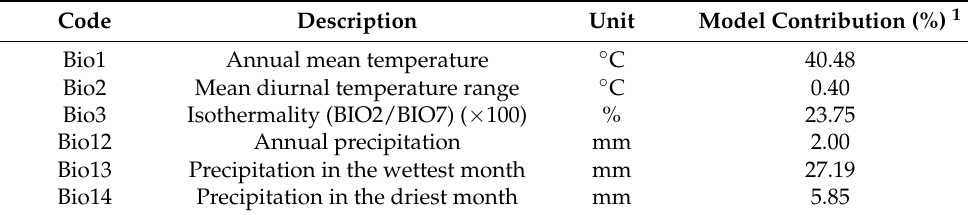
Table 1. Bioclimatic variables selected for modeling P . hysterophorus